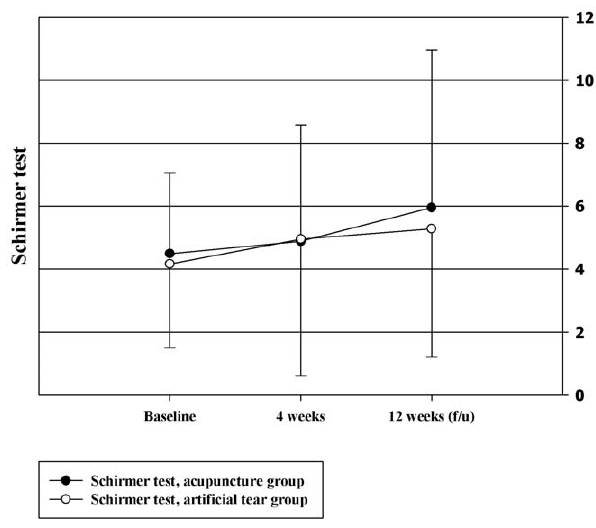
Figure 5. Schirmer I test.